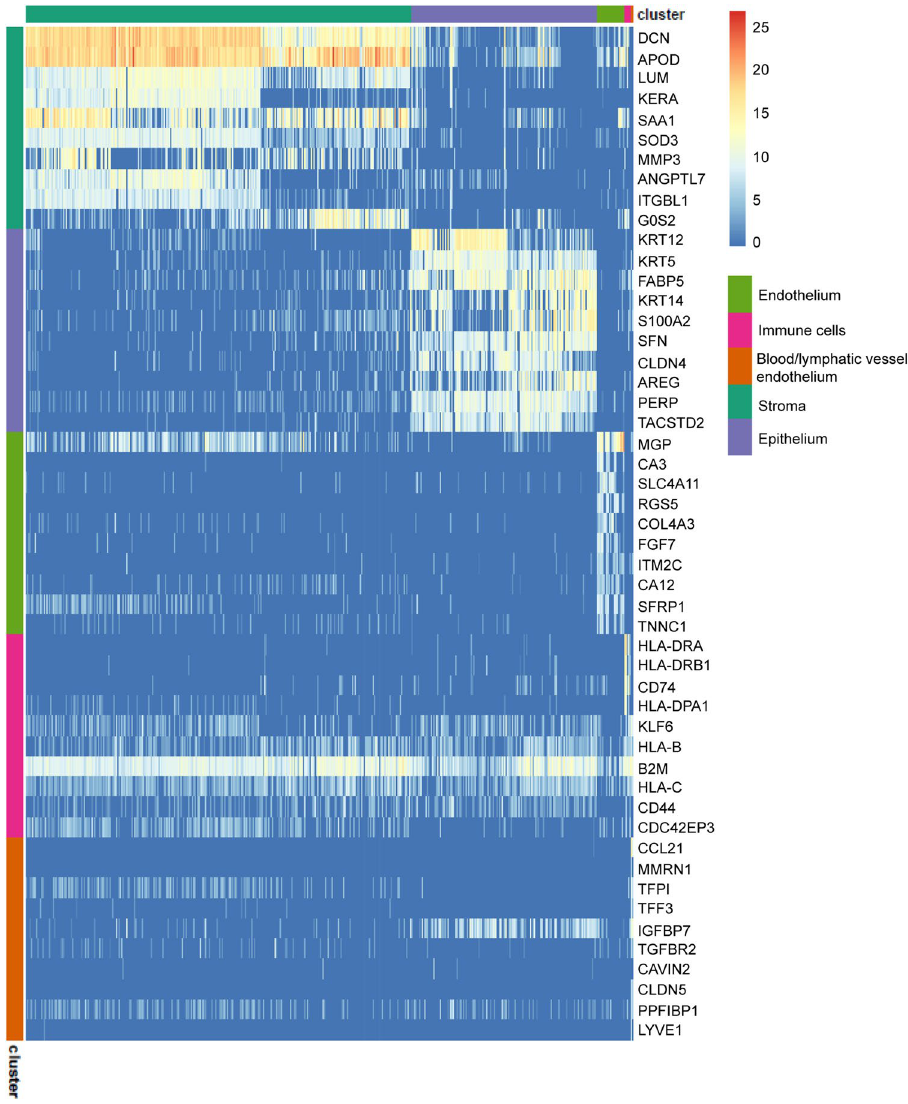
Figure 2. The heatmap of the top 10 differentially expressed genes for each cluster showed distinct transcriptomic profiles for the five major cell clusters and allowed cell cluster